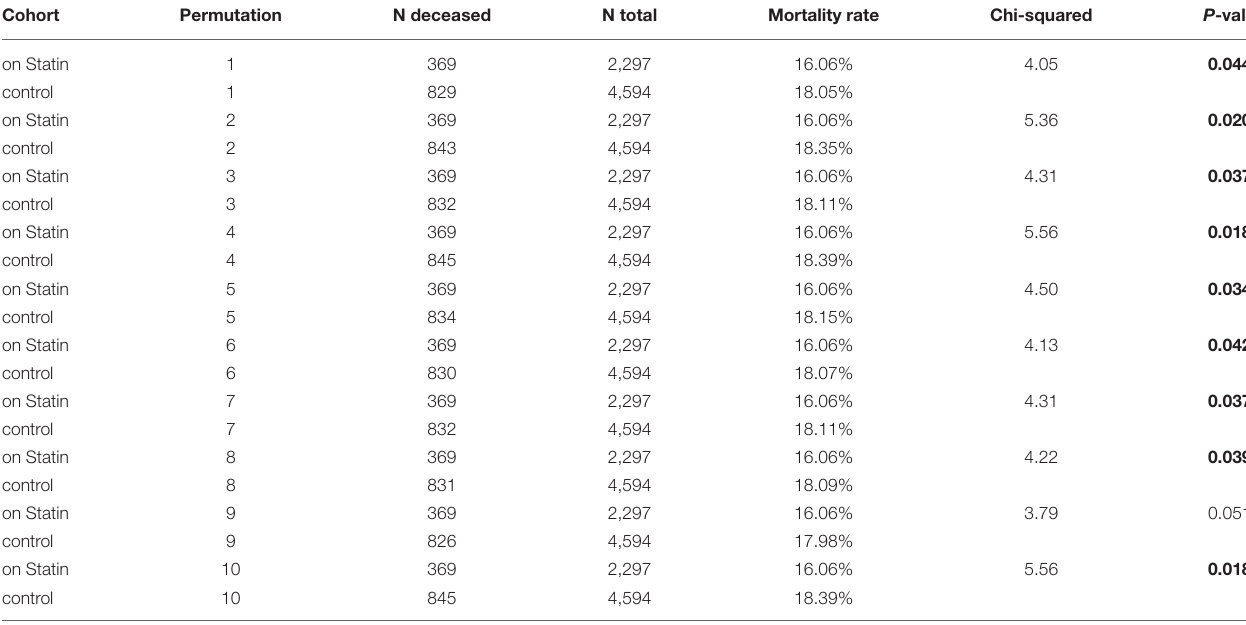
Bold indicates p < 0.05.